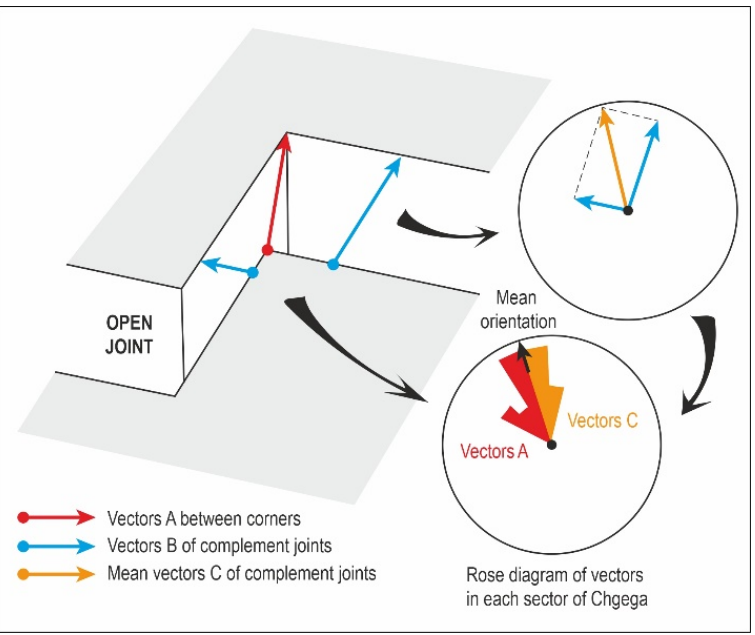
Figure 7. Graphic explanation of the measures taken in the open joints of Chgega and the data treatment performed. According to the scheme, we measured two types of vectors, A and B. Vectors A point out the orientation of the movement but they are scarce. To analyze more information, we added vectors B to calculate vectors C, which are an approximation of the orientation of the movement. Finally, we calculated the A and C average vectors in each sector of the mass movement.